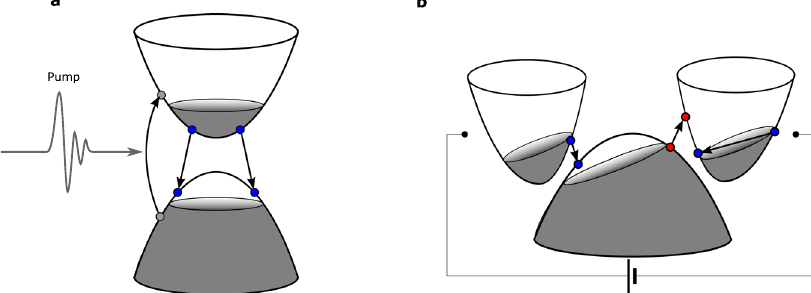
Fig. 1 | Comparison of population inversion from a conventional optical pumping setup and a current biased tilted Dirac node. a Schematic of popula- tion inversion achieved by a conventional optical pumping setup is shown. b Schematic of population inversion in current biased tilted Dirac nodes. The